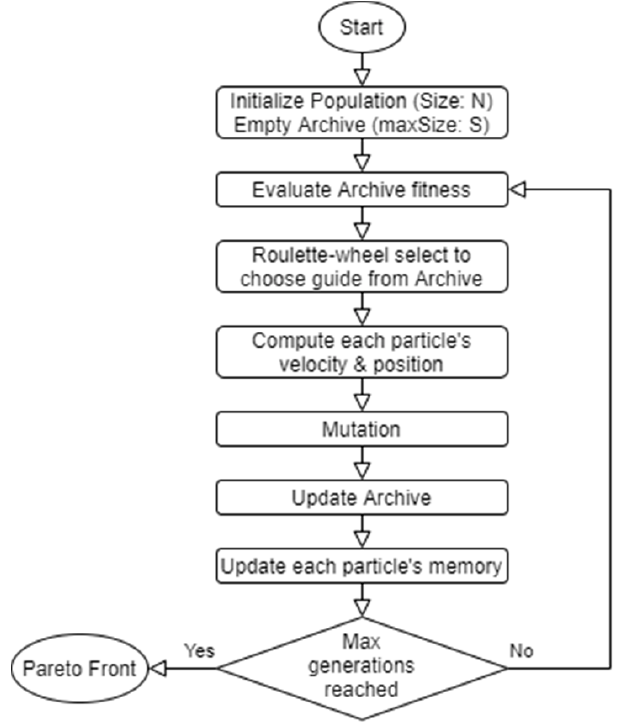
Figure 4. OMOPSO algorithm flowchart.